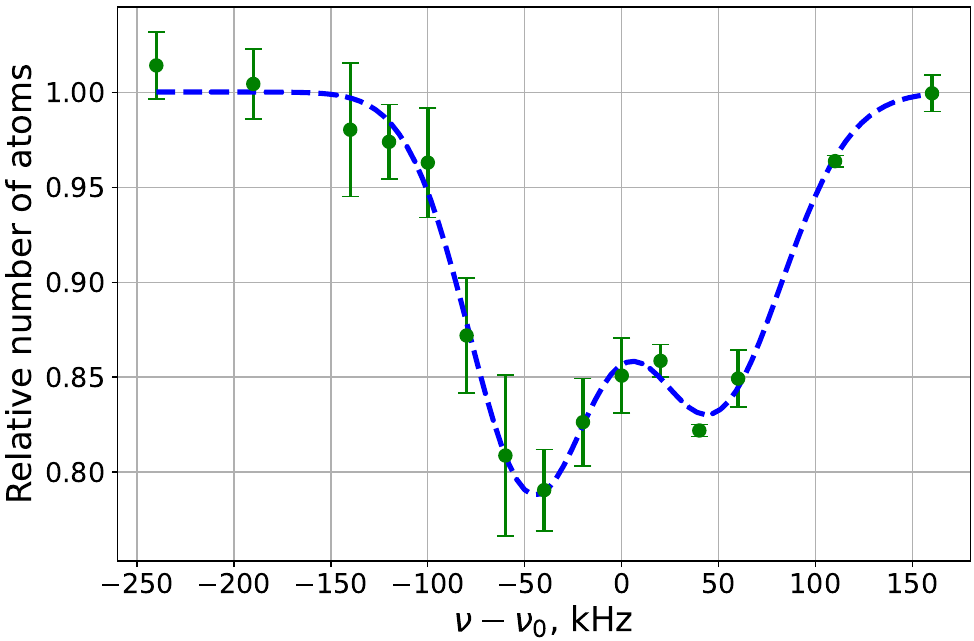
Figure A1. Typical 506.2nm cooling transition absorption spectrum in free space depending on the AOM frequency ν detuned from ν 0 = 200.985MHz. Dashed line shows the results of two Gaussian fit. The half-sum of their center frequencies was chosen as an origin on the frequency scale in further